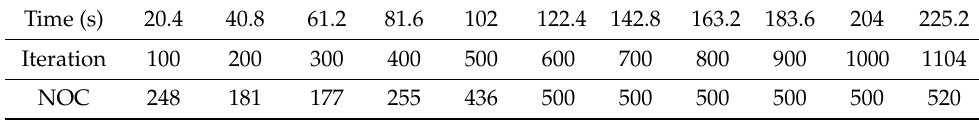
Table 4. Number of channels per 100 iterations. NOC, number of